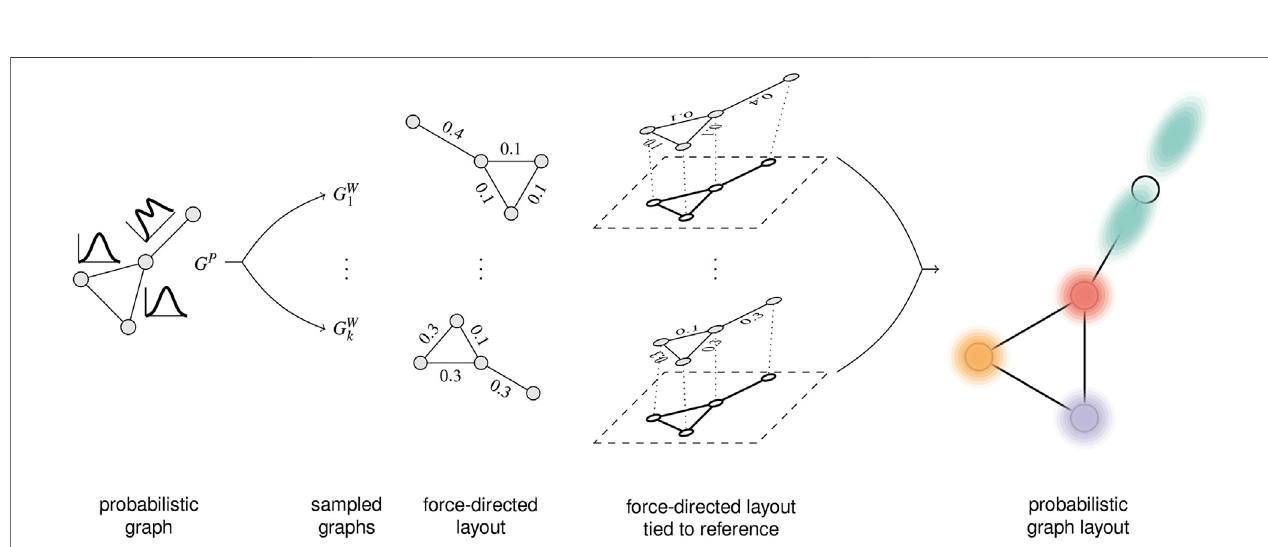
FIGURE 9 | Processing steps for sampling-oriented node-link visualization of uncertain graph data. Image: © 2017 IEEE. Reprinted, with permission, from Schulz et al.